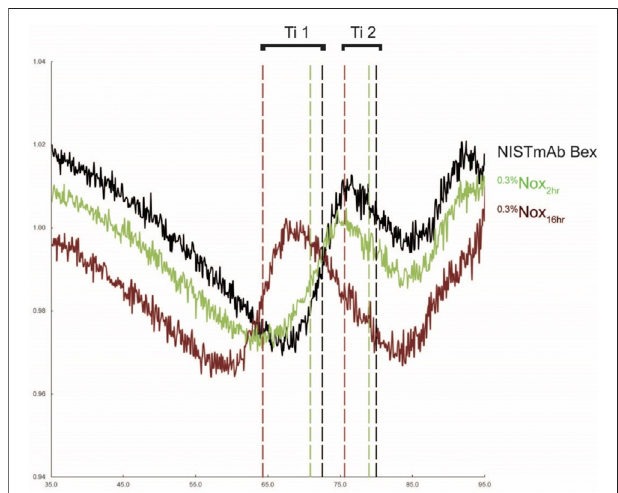
FIGURE8| Unfoldingpro fi lesofNISTmAbBex,alightlyoxidizedsample ( 0.3% Nox 2hr ), and a heavily oxdized sample ( 0.3% Nox 16hr ) with calculated in fl ection temperatures for the C H 2 (Ti 1 ) and C H 3 (Ti 2 ) domains